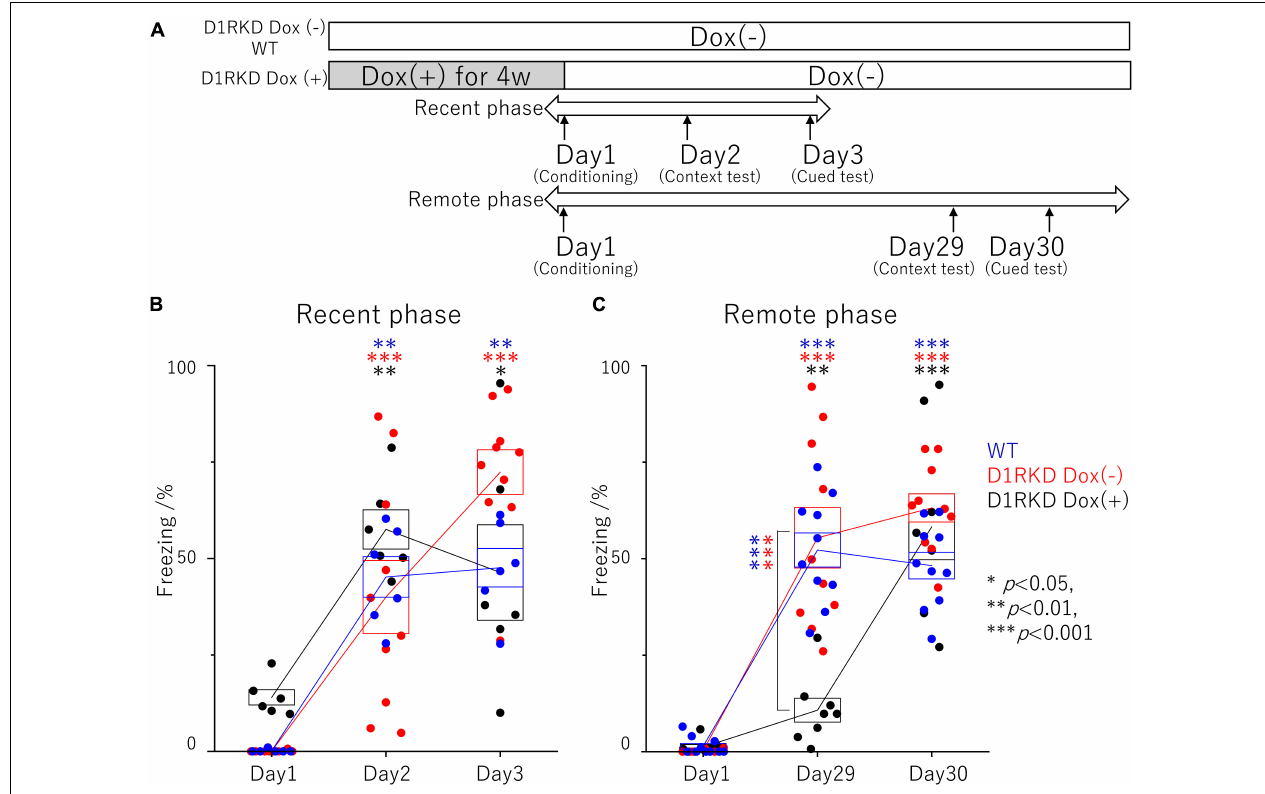
FIGURE 1 | Contextual and auditory cued fear conditioning test. (A) Experimental schedule. In the D1RKD Dox (+) group, Dox (2 mg/mL) was administered for 4 weeks prior to the commencement of the experiment and until after the completion of conditioning as the learning session on Day 1, with mice provided drinking water without Dox thereafter. The D1RKD Dox (–) and wild-type (WT) groups were always given only Dox-free water. Conditioning on Day 1, context test on Day 2, and auditory cued test on Day 3 were conducted for recent phase tests in all three groups [WT; n = 6, D1RKD Dox (–); n = 10, D1RKD Dox (+); n = 6]. On the other hand, Conditioning on Day 1, context test on Day 29, and cued test on Day 30 were conducted for remote phase tests in all three groups [WT; n = 10, D1RKD Dox (–); n = 10, D1RKD Dox (+); n = 8]. (B) In the recent phase tests, the freezing time of mice was recorded for all three groups during the context tests of Day 2 and the auditory cued tests of Day 3 as the test session, ∗ p < 0.05; ∗∗ p < 0.01; ∗∗∗ p < 0.001. (C) In the remote phase tests, the freezing time of mice was recorded for all three groups during the context tests of Day 29 and the auditory cued tests of Day 30 as the learning session. The blue circles indicate the values of WT groups,